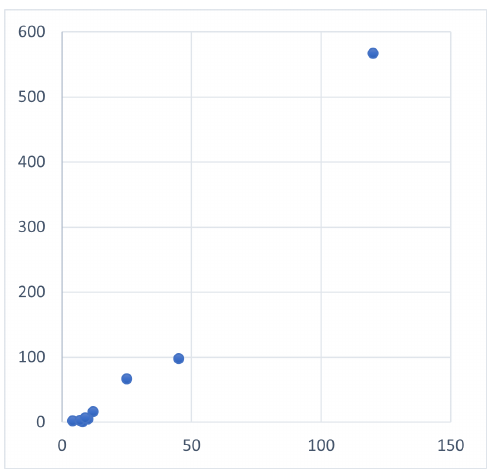
Figure 3. Representation of the transposed matrix of the above